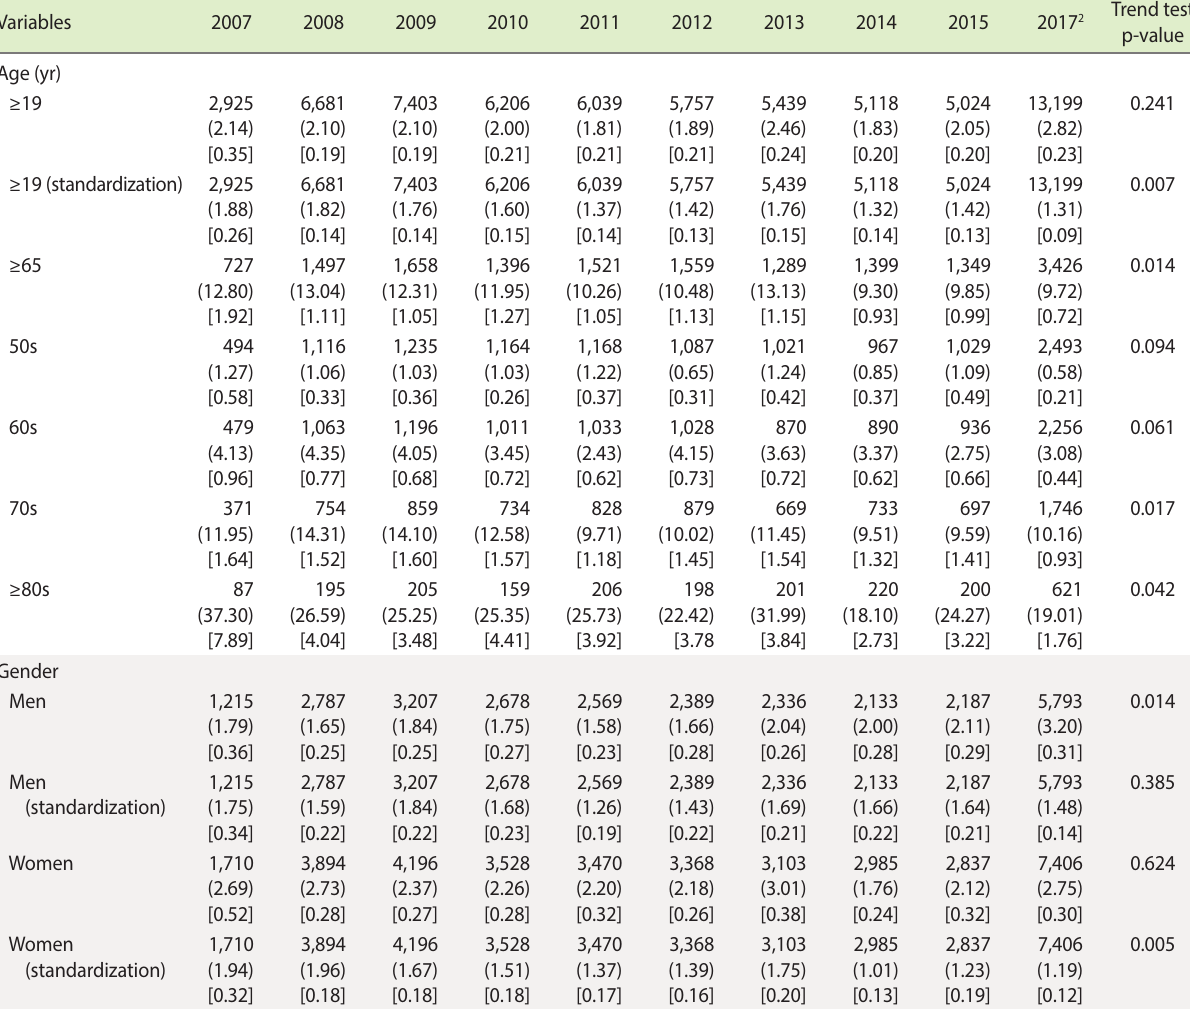
Table 1. Changes in edentulism prevalence 1 according to age and gender